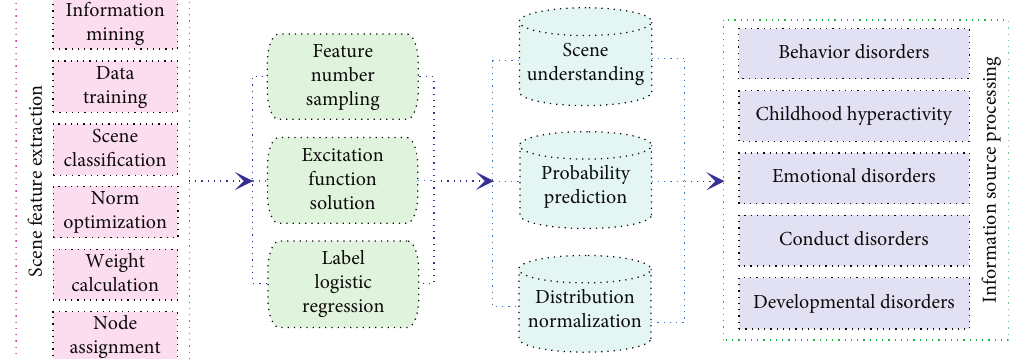
Figure 1: Scene matching framework for children’s psychological distress based on deep learning